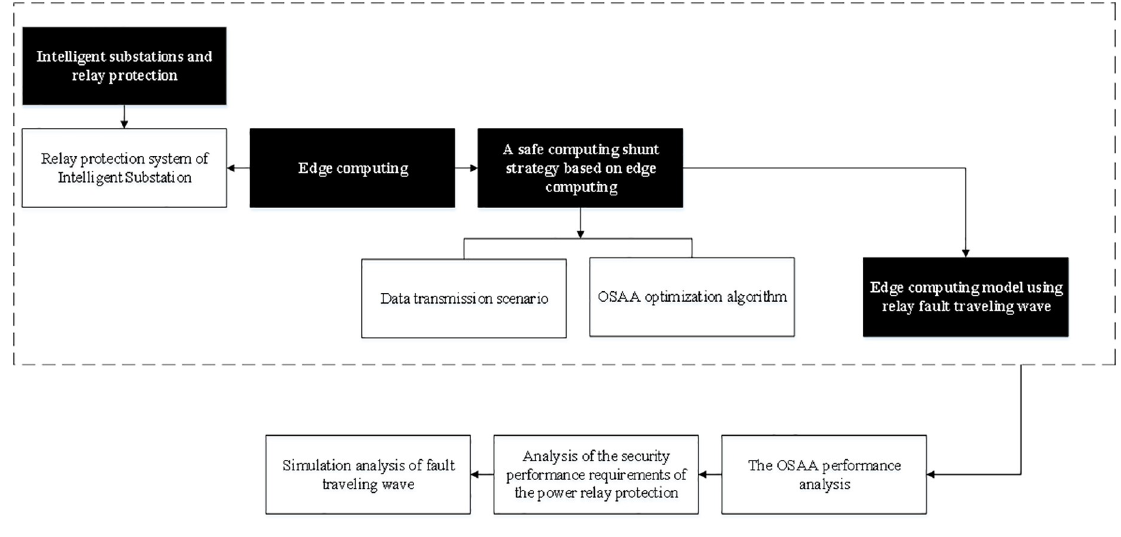
Fig 1. The overall research process.